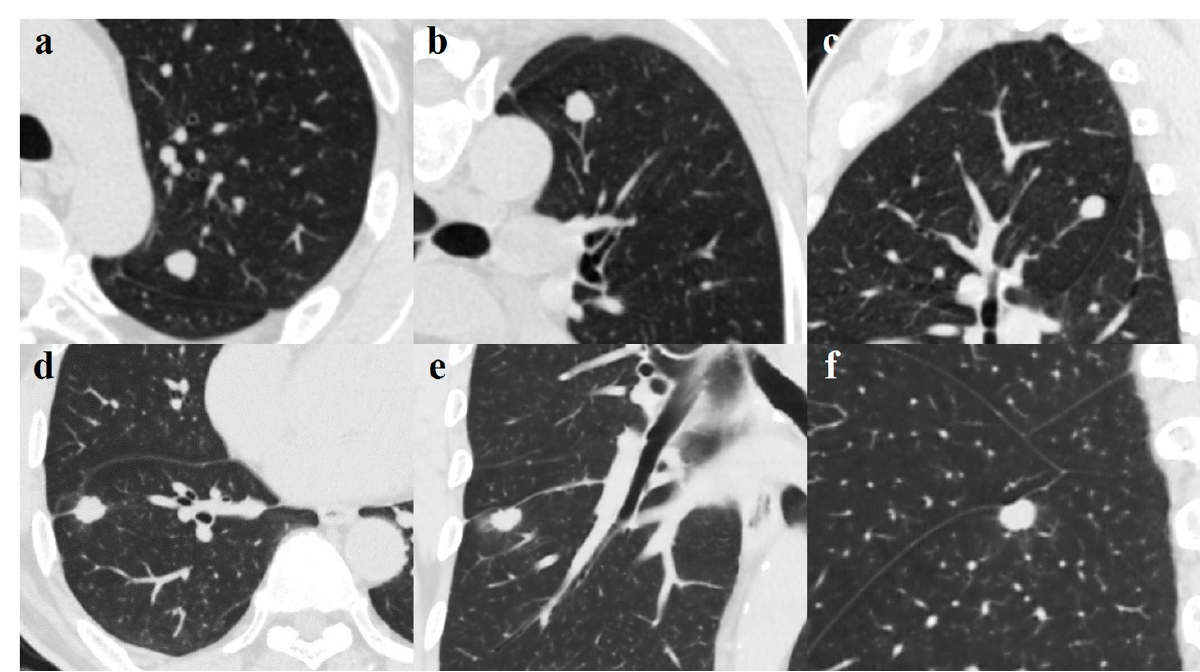
Figure 3. ( a – c ). A 49-year-old man with pulmonary tuberculoma in the upper lobe of the left lung. Axial image ( a ) showing a round-like well-defined solid nodule measuring 1.14 cm; blood vessel convergency can be seen on the reconstructed coronal ( b ) and sagittal ( c ) views. The lesion was confirmed on pathological diagnosis as a tuberculoma. d-f. A 65-year-old man with lung adenocarcinoma in the right lower lobe. Axial image ( d ) demonstrates a well-defined juxta-fissural solid nodule measuring 1.47 cm with lobulated margin, short burr, and pleural indentation sign. Perilesional ground-glass opacification and a pleural indentation sign can be seen on the coronal ( e ) and sagittal ( f ) views. The lesion was proven on pathological diagnosis to be a moderately differentiated adenocarcinoma.